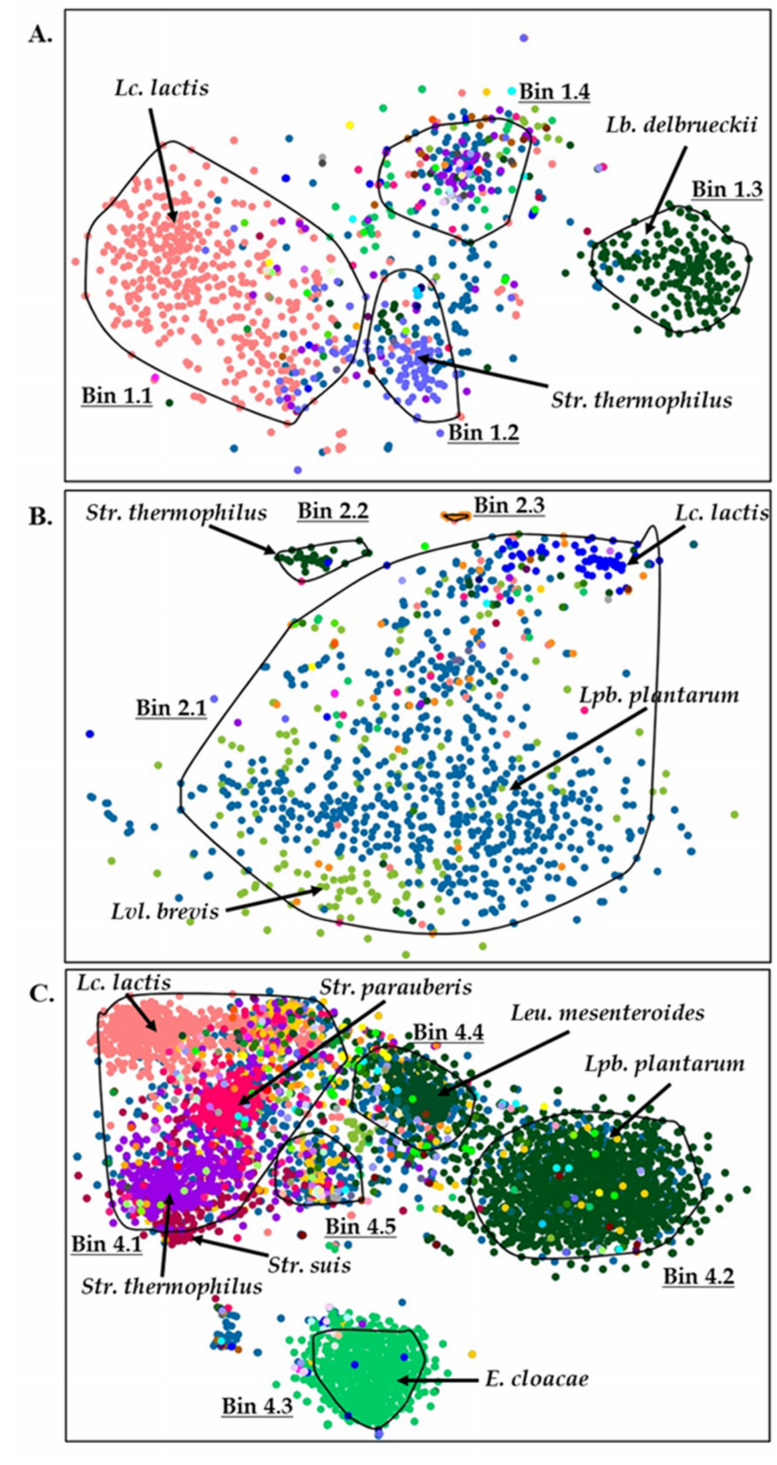
Figure 6. Bins of metagenomics scaffolds of Industrial sample 1 ( A ) and Homemade samples 2 ( B ) and 4 ( C ) of Feta cheese. Dots of same colors represent scaffolds that derived from the same species which are presented within the